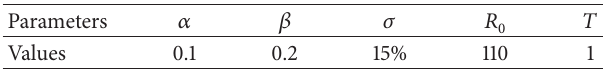
Table 5: Parameters and initial value for the Vasicek interest rate